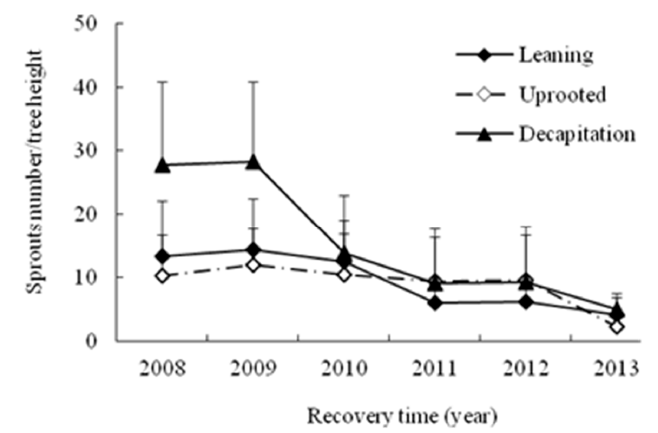
Figure 4. The annual change of total sprouts number per tree height for three damaged types of trees with increasing year.